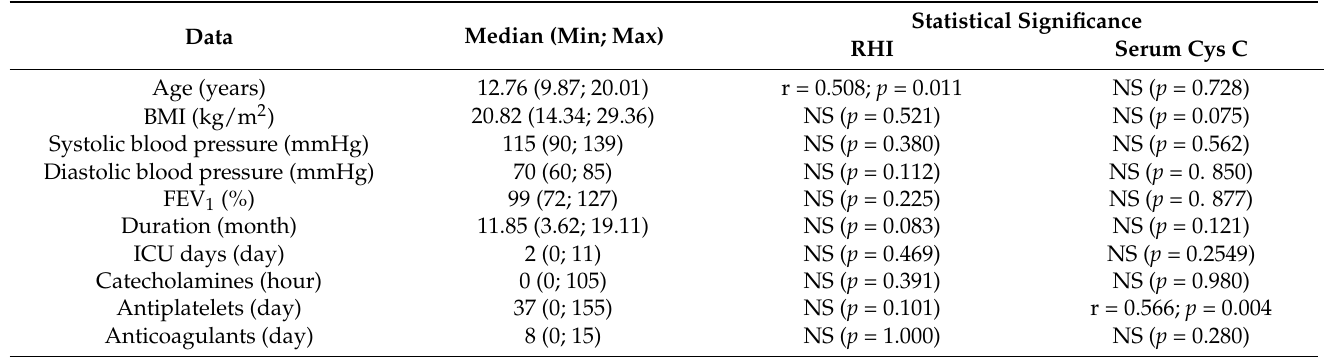
Table 2. MIS-C: file properties and correlations with RHI and Cys